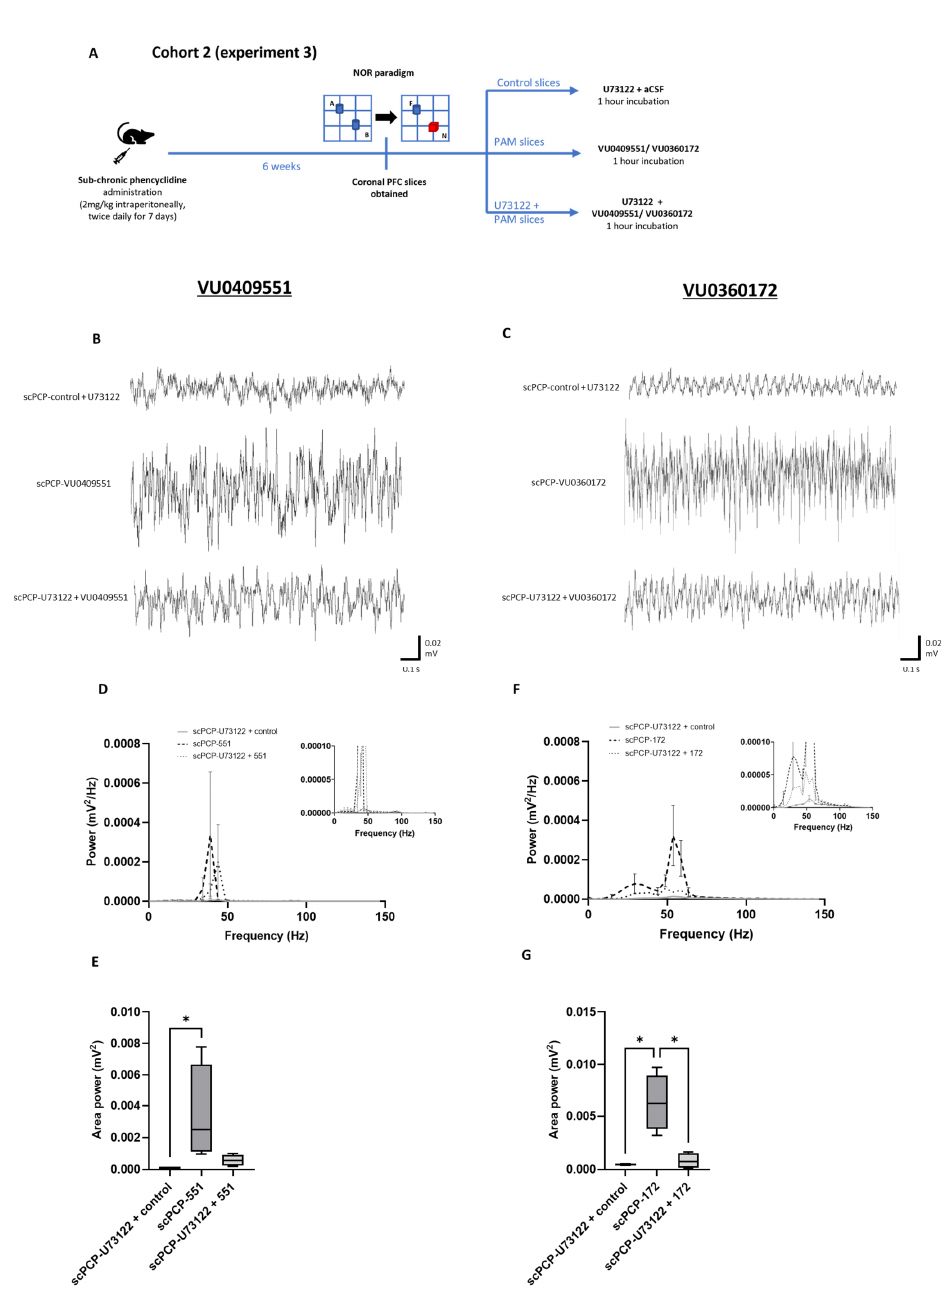
Figure 7. U73122 (10 µ M) reduced the activity of VU0409551 or VU0360172 in scPCP slices in terms of gamma power. ( A ) Schematic illustrating the experimental protocol for Cohort 2, experiment 3. A, B, blue; identical objects. F, blue; familiar object. N, red; novel object. ( B , C ) Representative traces showing oscillatory activity in PFC slices from scPCP-treated rats without PAM application with U73122 alone (scPCP-control + U73122), and scPCP slices treated with U73122 followed by VU0409551 or VU0360172. The U73122 was present during PAM incubation but was washed off before oscillations were evoked. Power spectral analyses show the effect of U73122 alongside ( D ) VU0409551, and ( F ), VU0360172 on amplitude power ( n = 4 per group, analysed using a Friedman’s test followed by Dunn’s tests). Graph insets more clearly illustrate data in low power ranges. Box plots show the median (whiskers max–min) area power in slices incubated in ( E ), VU0409551 ( n = 4 per group) or ( G ), VU0360172 ( n = 4 per group; both analysed using Friedman’s tests followed by Dunn’s tests; * p < 0.05, significant increase in area power in with PAM incubation relative to control; * p < 0.05, significant decrease in area power following U73122 + VU0360172 incubation relative to VU0360172